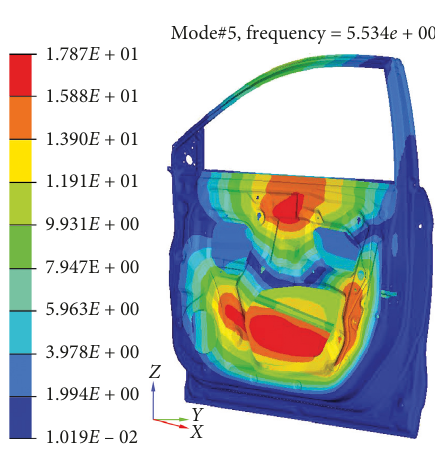
Figure 2: Fifth-order structure mode of the door.